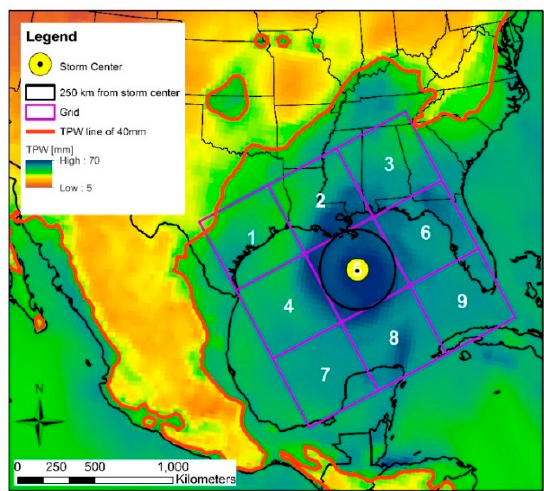
Figure 4. The amount of total precipitable water (TPW) at 00 UTC 29 August 2005 for Hurricane Katrina. The 9-cell grid is centered on the TC position and oriented according to storm forward motion. TPW on the left (cells 1, 4, 7) and right side of a storm (cells 3, 6, 9) are measured separately. Cell 2 is ahead of the storm and cell 8 is behind the storm. They are not used in the calculation of TPW on the left or right sides of the storm. The shortest distance to the TPW contour line of 40 mm (red line) from the storm center is measured.